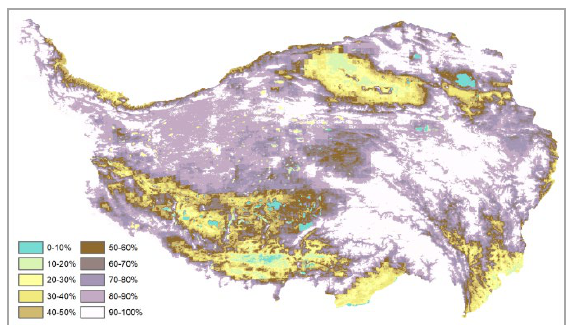
Figure 1 . The proportion of SCDs in the annual snow accumulation period on the TP (1989 － 2018) Qaidam Basin, south-western TP, Yarlung Zangbo Canyon and the south Hengduan Mountains have rather short snow days, where the SCDs are less than 60 days and no more than 30% of the annual snow accumulation period. Although they are all featured by less SCDs, their causes are different: (i) Affected by arid climate, the precipitation on the Qaidam Basin is rare and mostly instantaneous snow, which is difficult to maintain the snow cover. (ii) For the Yarlung Zangbo Canyon and the south Hengduan Mountains, the temperature is relatively higher compared with the other parts on the TP, which is not favorable for snow formation. (iii) In contrast, the south-western TP is a rather cold region supporting snow cover formation and Figure 2 . (a) The annual trend of SCDs on the TP (1989 － maintenance. But controlled by the cold high pressure center in 2018) and (b) the region with 95% confidence level (p < the winter, there is less water vapour transport into this region, responsible for the observed limited snow accumulation.